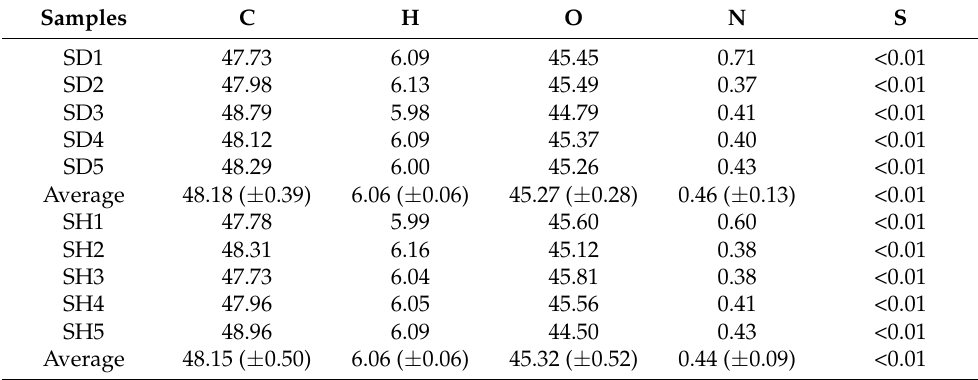
Table 1. Ultimate analysis of sawdust (SD) and shavings (SH) samples (%).